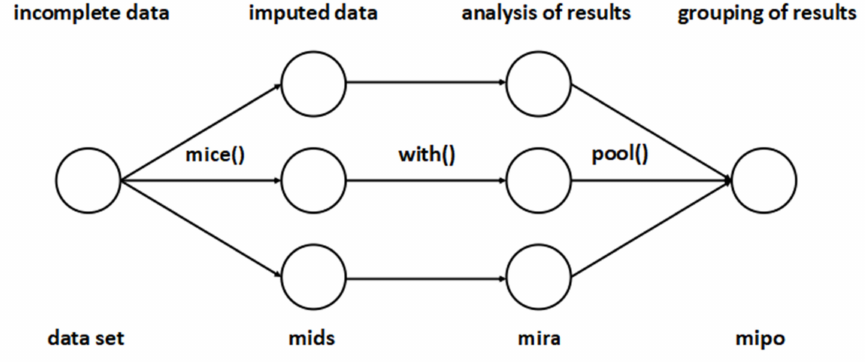
Figure 2. Main steps used in multiple